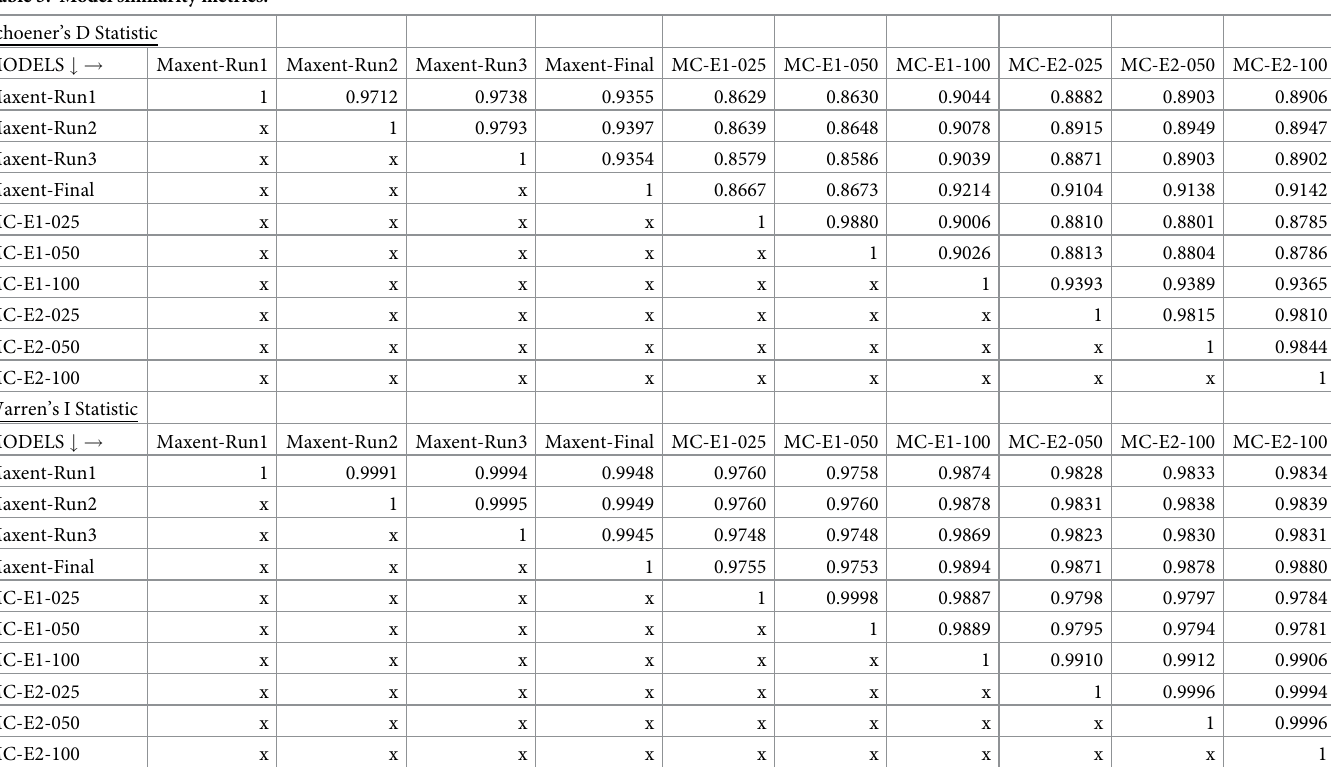
Table 3. Model similarity